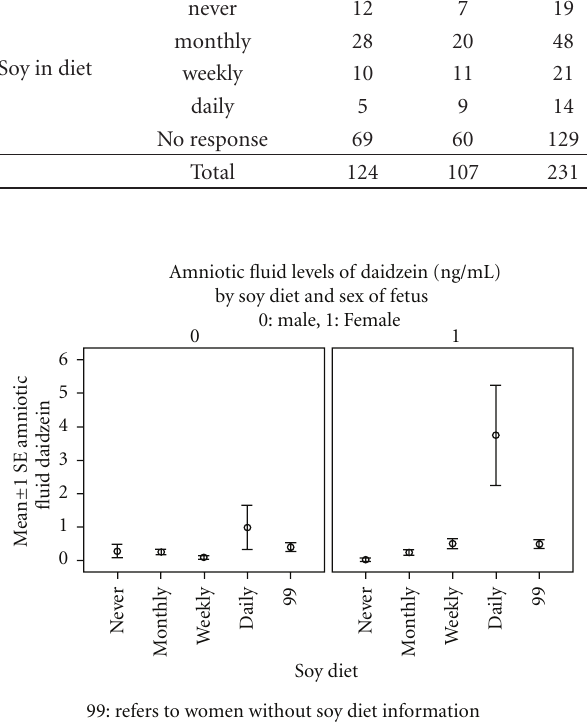
Figure 3: The amniotic fluid levels of Daidzein (ng/mL) by soy diet and sex of